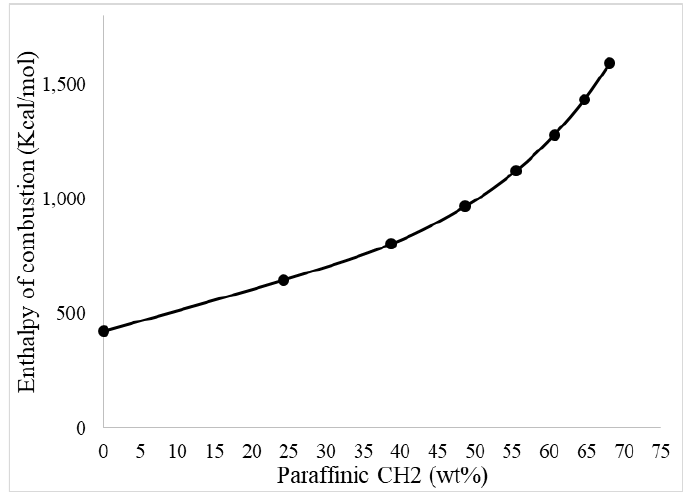
Figure 5. The effect of weight percentage of CH2 on enthalpy of combustion for olefins .